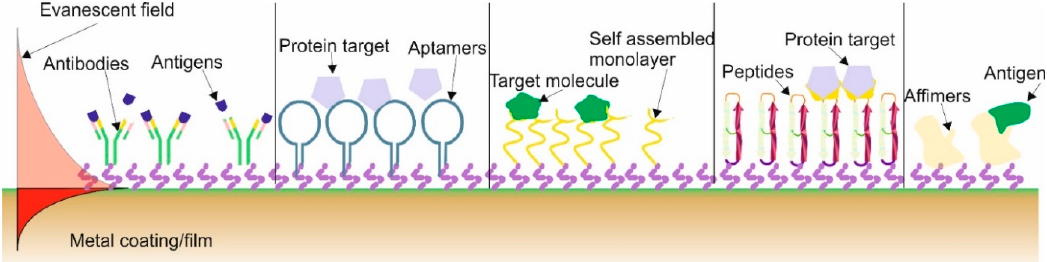
Figure 6. Schematic of a biofunctionalised metal-coated optical fiber surface with the most commonly used strategies to attract specific analytes.